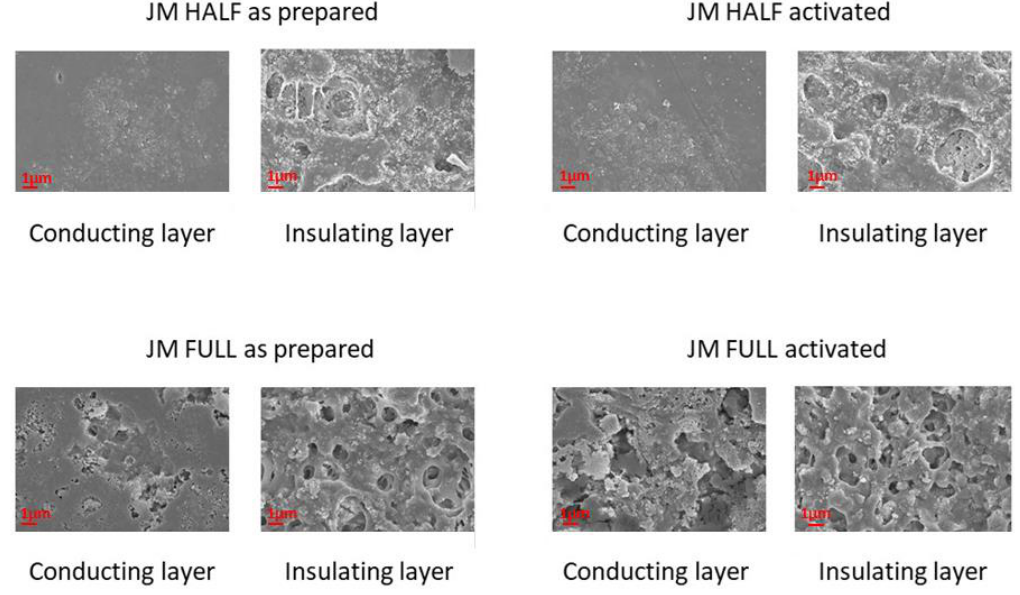
Figure 2. SEM images of 20 µ m HALF and FULL JMs both before and after activation with the liquid electrolyte. Magnification: 20,000 × .